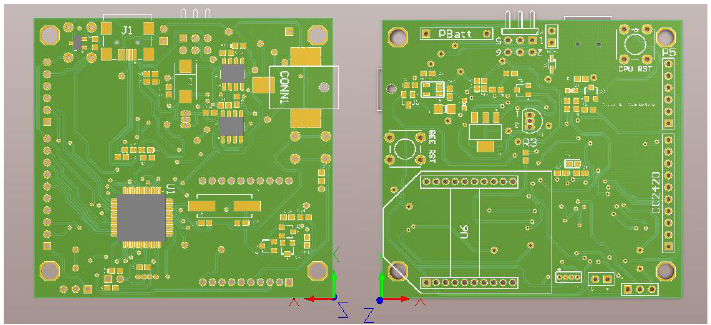
Figure 3. WiSe Mote PCB